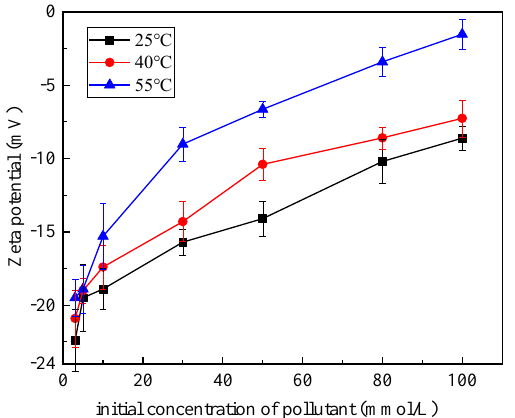
Figure 10. Influence of temperature on zeta potential of suspension system.